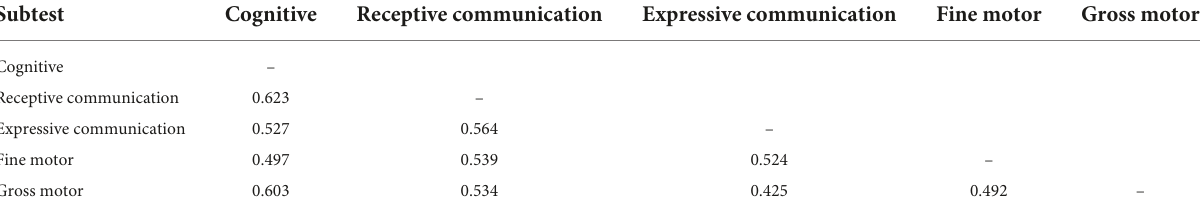
TABLE 3 Correlation matrix of the scaled scores in 24 months age group.